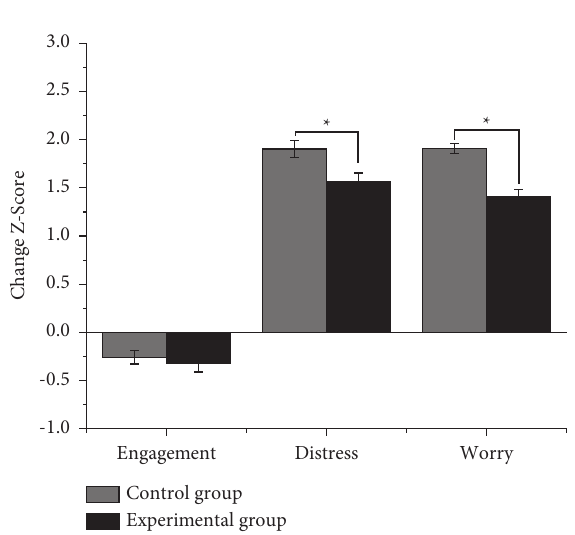
Figure 13: The average score for the control and experimental groups. The error bars represent the standard error of the difference between the two groups. Asterisks denote significant differences between the control and experimental groups. Change Z -score- � post-test score − pretest